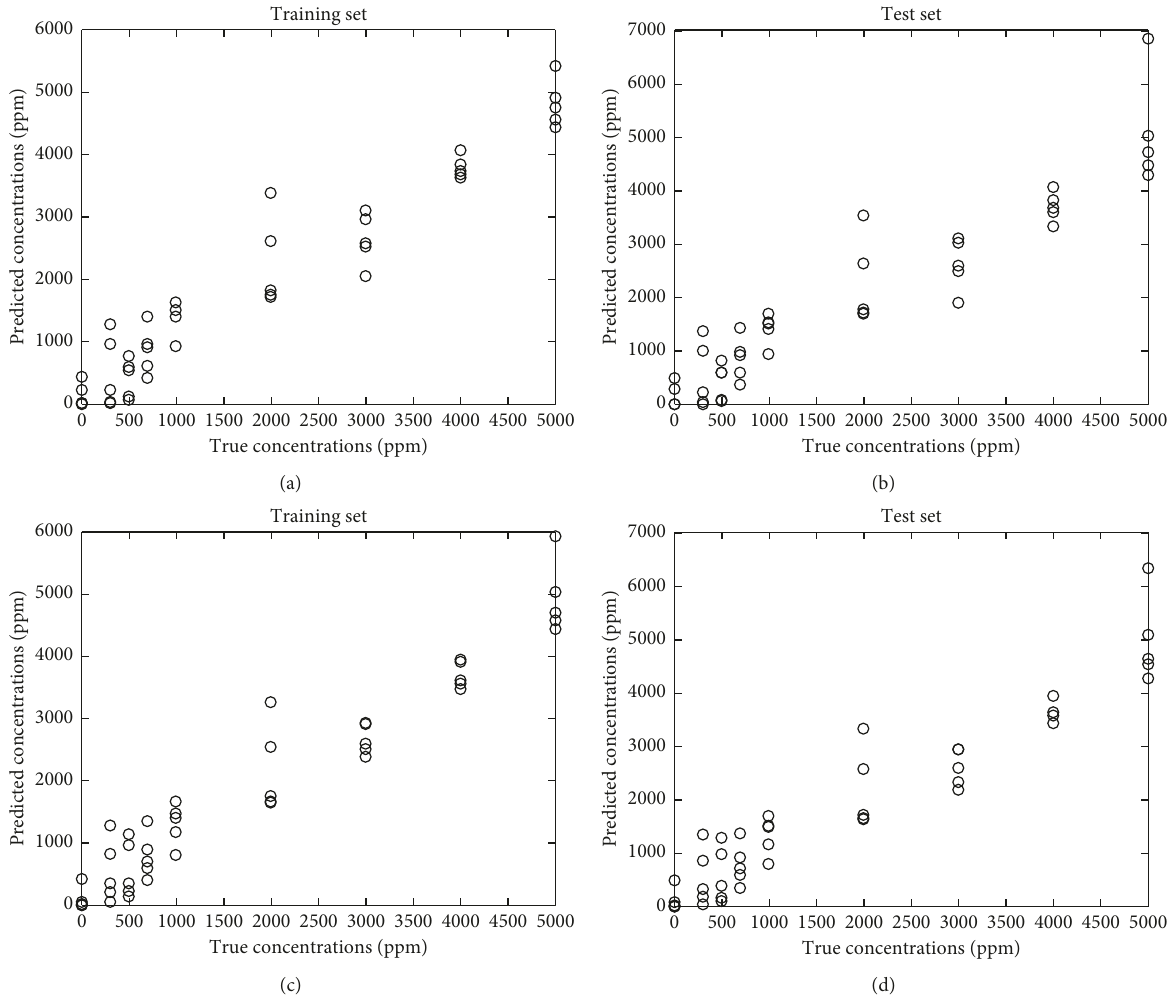
Figure 5: Predicted versus expected concentrations of training/test sets for transformer oil. (a) % RMSE (c) % RMSE 24.16, and (d) % RMSE (cid:26)